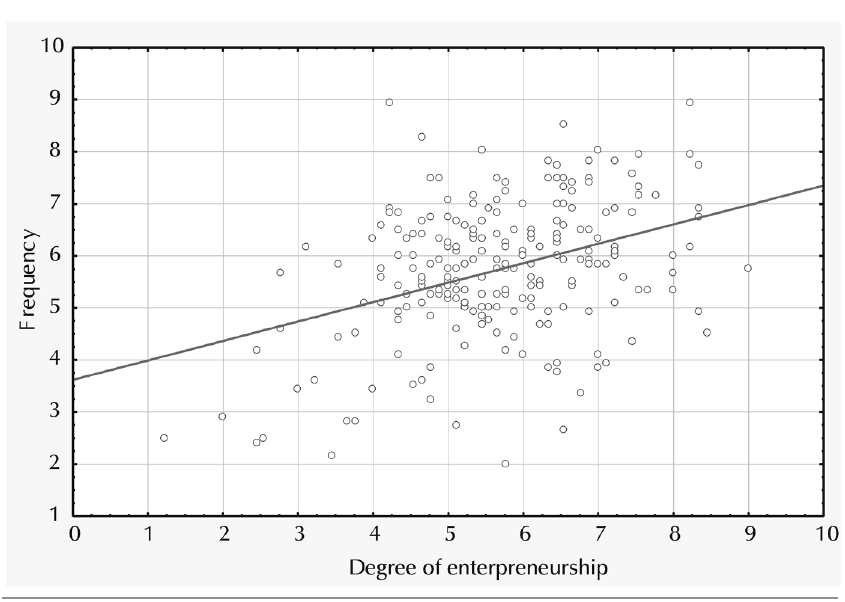
Scatterplot of frequency and degree of entrepreneurship